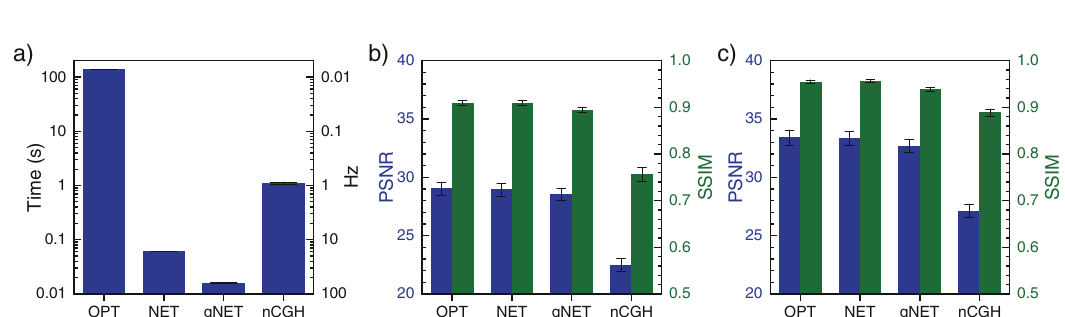
Fig. 5 | Performance comparison. a Inference times. OPT refers to the DEH cal- culated by optimization, NET refers to the DEH calculated by DEHNet before quantization, and qNET refers to the DEH calculated by DEHNet. We achieved a frame rate of 62Hz in qNET, which is 8600 (70) times faster than that obtained in OPT (nCGH). The OPT inference time does not include the rendering time of the varifocal images. b The PSNR and SSIM were evaluated for the 512 resolution dataset. The presented PSNR and SSIM values represent the mean values of all images in the dataset with respect to the 21 rendered images for each scene. OPT,